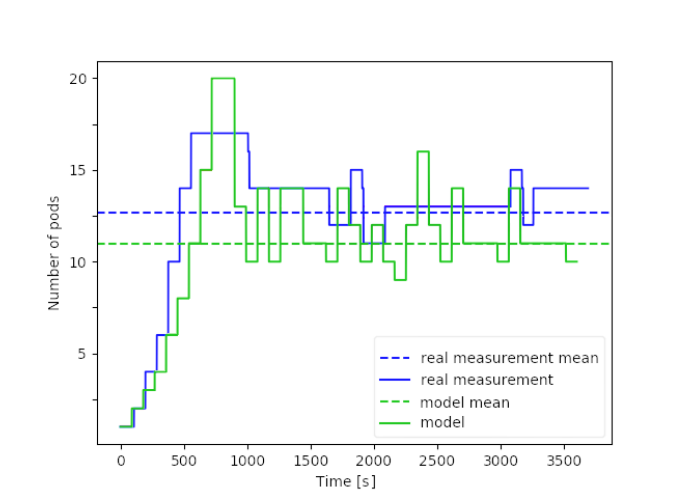
Figure 5. Validative example of single elastic resource model by Algorithm 3 compared to a real Kubernetes Horizontal Pod Autoscaler (HPA) pod count